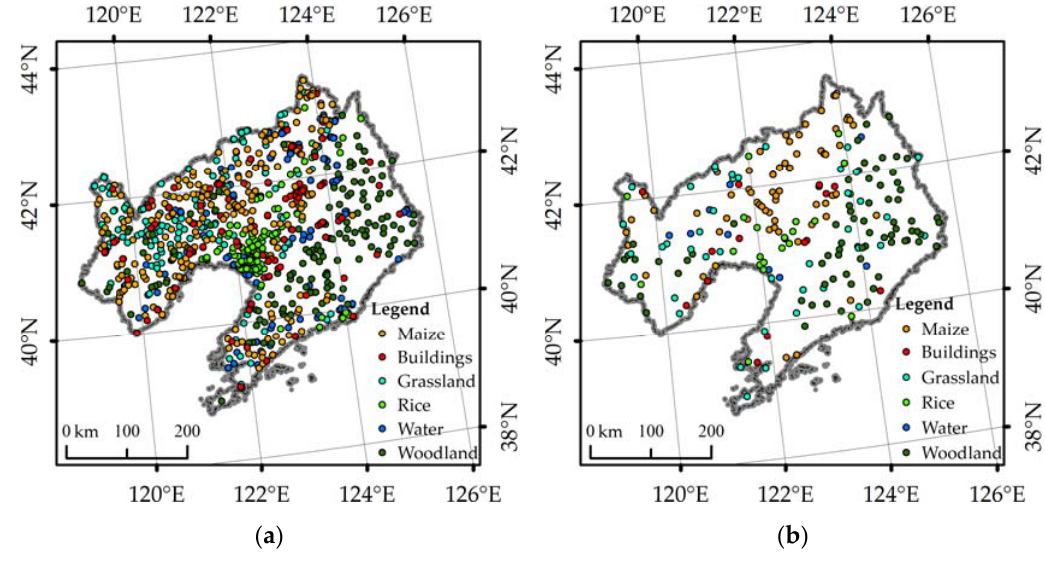
Figure 3. Distribution of samples. ( a ) Training samples; and, ( b ) Validation samples.